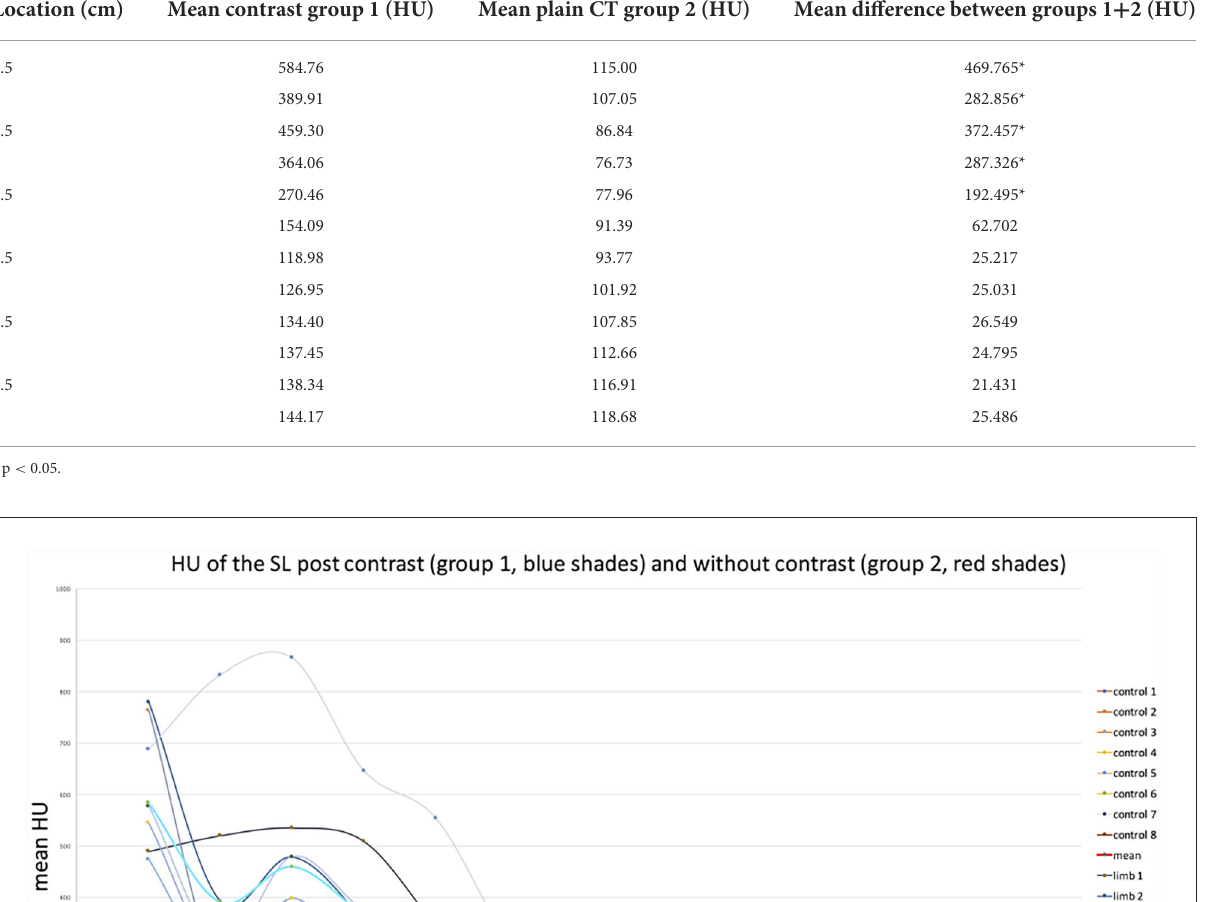
TABLE 1 ROI along the outline of the suspensory ligament in transverse CT images measured in mean HU at 6 levels, from 0.5cm to 6cm distal to the subchondral bone plate of Mc3, in 0.5cm intervals. Location (cm)